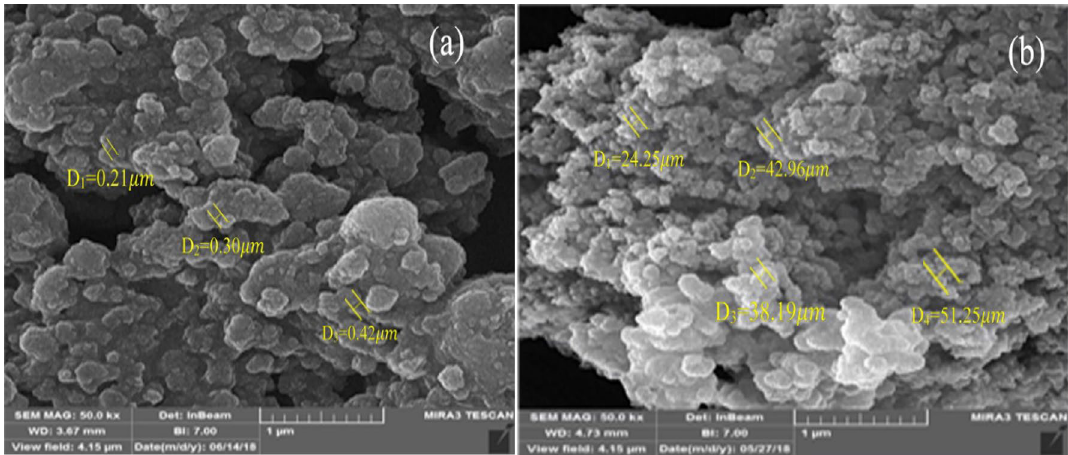
Figure 2. The FE-SEM images of ( a ) MIL-101(Cr) and ( b ) HMTA-BAIL@MIL-101(Cr).